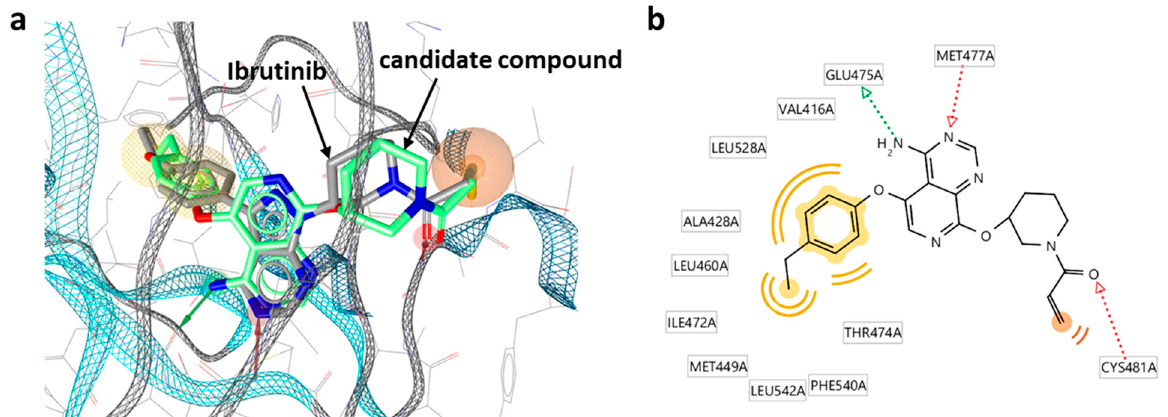
Figure 6. Hypothetical complexes of candidate inhibitors from DeepSARM and BTK. ( a ) Superposition of a candidate inhibitor containing Key 2-21 onto the crystallographic binding mode of ibrutinib. Pharmacophore features including two hydrogen bond acceptors, one hydrogen bond donor, one residue bonding point, and two optional hydrophobic features are represented as red arrows, green arrow, and orange/yellow sphere, respectively. ( b ) A corresponding diagram of candidate inhibitor–BTK interactions is shown.